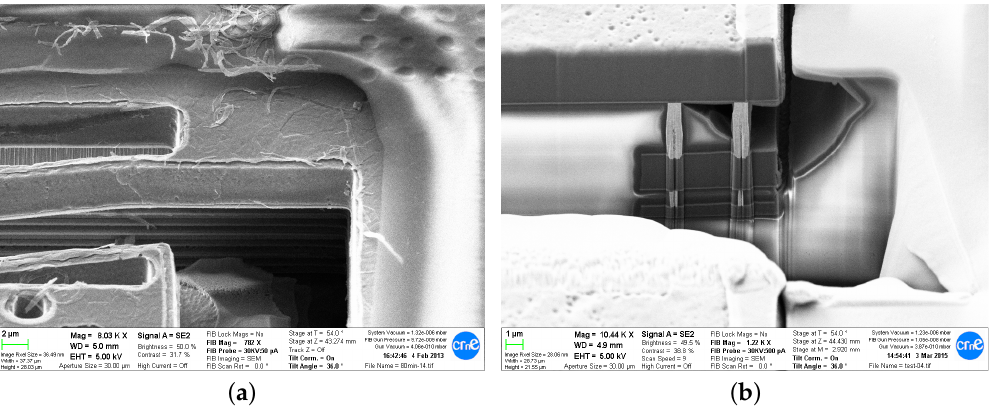
Figure 8. Top Ti/TiN ARC damage on TM2 layer on Accused chip after 80 min release ( a ); and FIB cut of an unprotected pad after 85 min release of Released ( b )—the etching around the pad does not pose any danger to the electrical